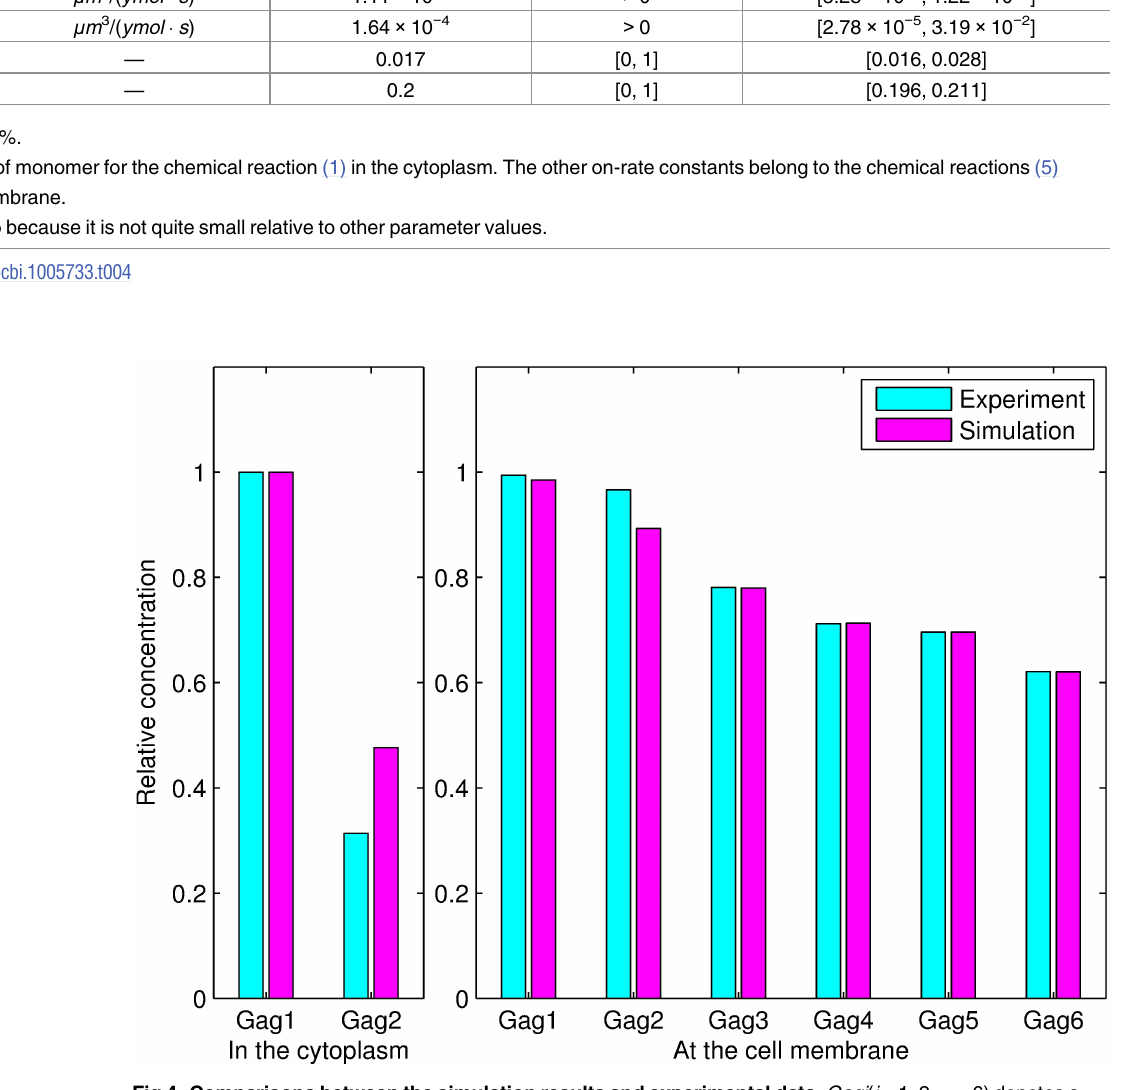
Fig 4. Comparisons between the simulation results and experimental data. Gagi ( i = 1, 2, (cid:1)(cid:1)(cid:1) , 6) denotes a polymerwith i monomers. The subfigure on the left illustrates the comparisons betweenthe simulationand experimental results for Gag monomers and dimers in the cytoplasm. The subfigure on the right shows the differences betweenthe simulationand experimental results for the six types of polymers at the plasma membrane. The concentration of each polymerwas normalized by dividingby the concentration of Gag monomer in the